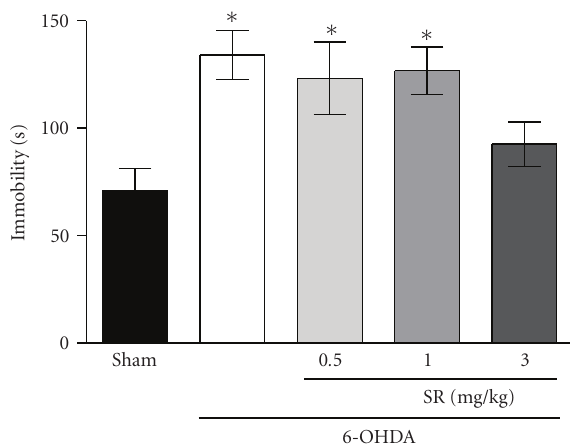
Figure 1: E ff ects of acute administration of SR141716A (0.5, 1, and 3mg/kg), i.p. 30 minutes before the second session of forced swim test on 6-OHDA-treated rats. Results are expressed as mean immobility time ± SEM in comparison to sham controls. Statistical analysis was performed by one-way ANOVA followed by Newman- Keuls post hoc test. ∗ P ≤ .05 compared to the sham group ( n = 8 per